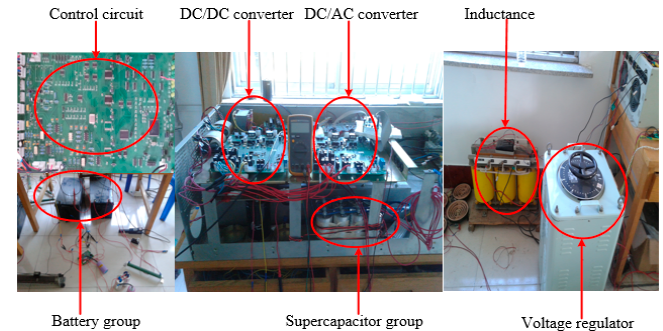
Figure 13. Layout of experimental platform.